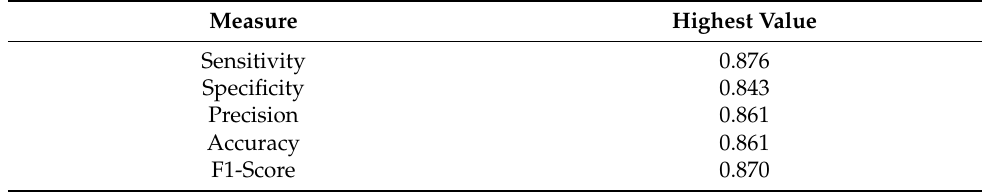
Table 4. Performance metric of the proposed method.